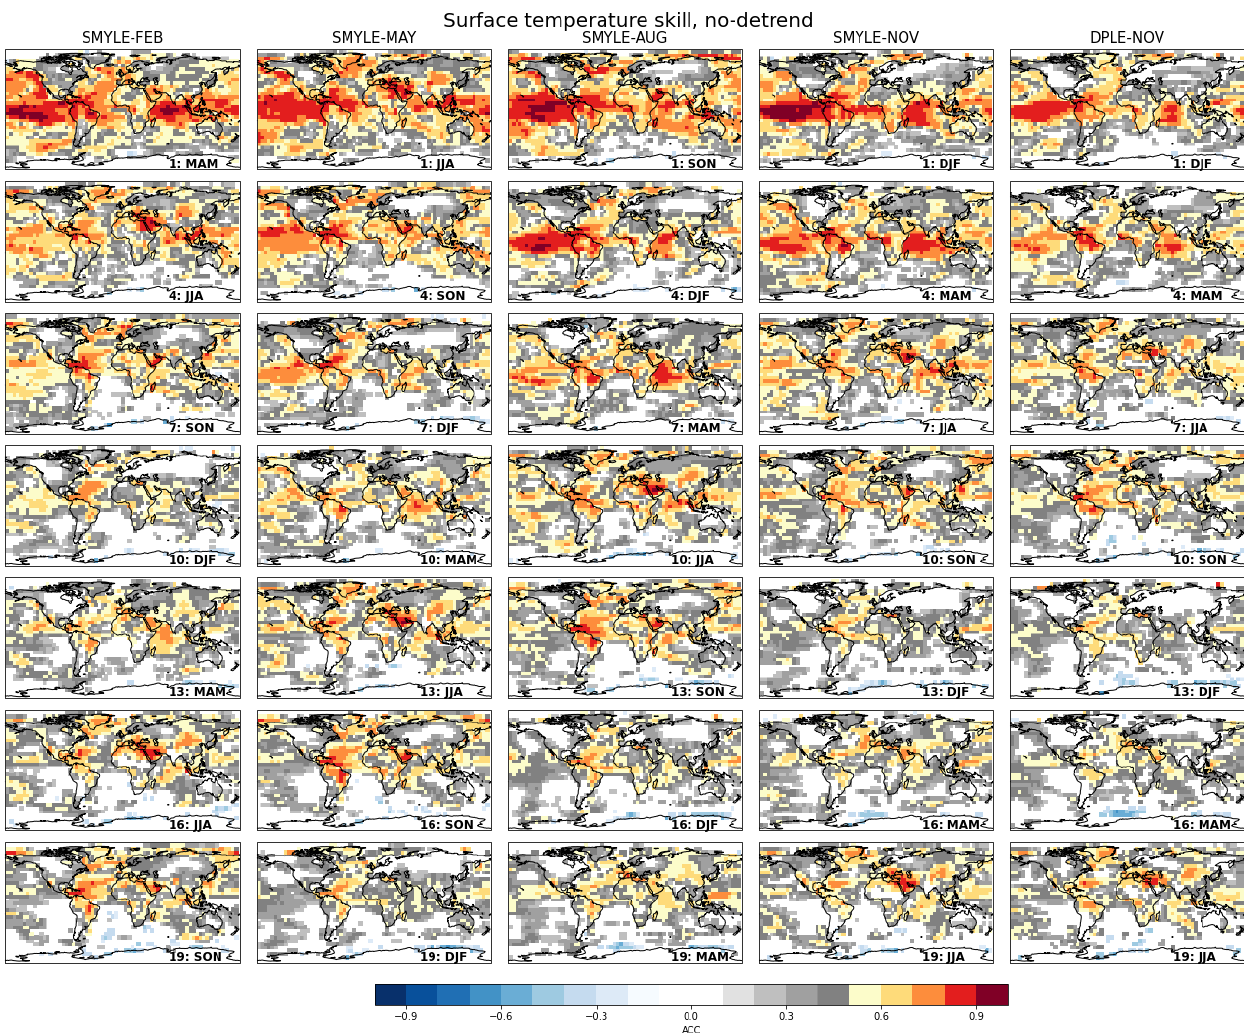
Figure B1. Equivalent to Fig. 1 (surface temperature ACC) but without removing a linear trend.